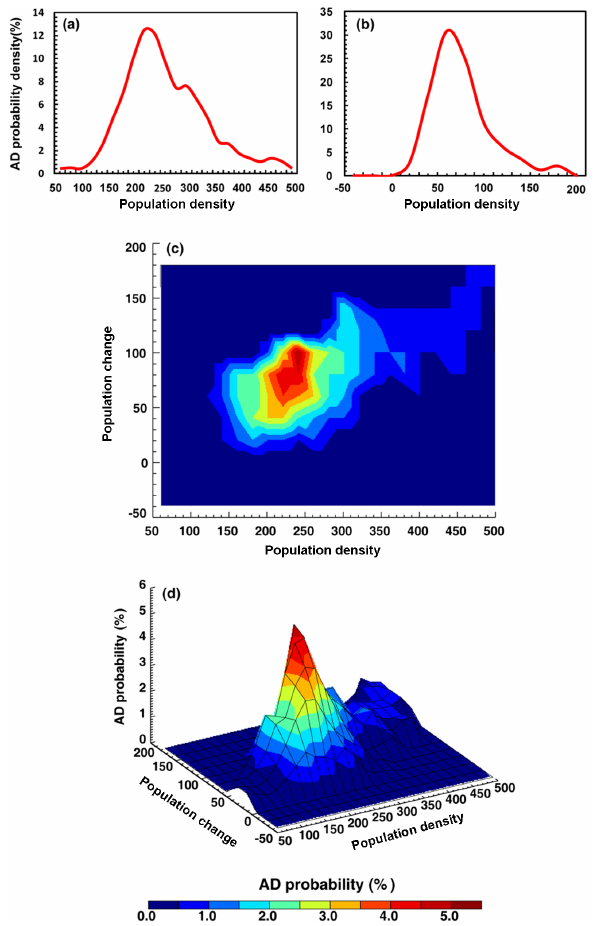
Figure 14. Anthropogenic dust (AD) probability as a function of population density (personskm − 2 ) (a) , population change (per- sonskm − 2 ) (b) , 2-D (c) , and 3-D (d) of AD probability distribution as a function of population density and change in typical cropland- dominated semi-arid regions in